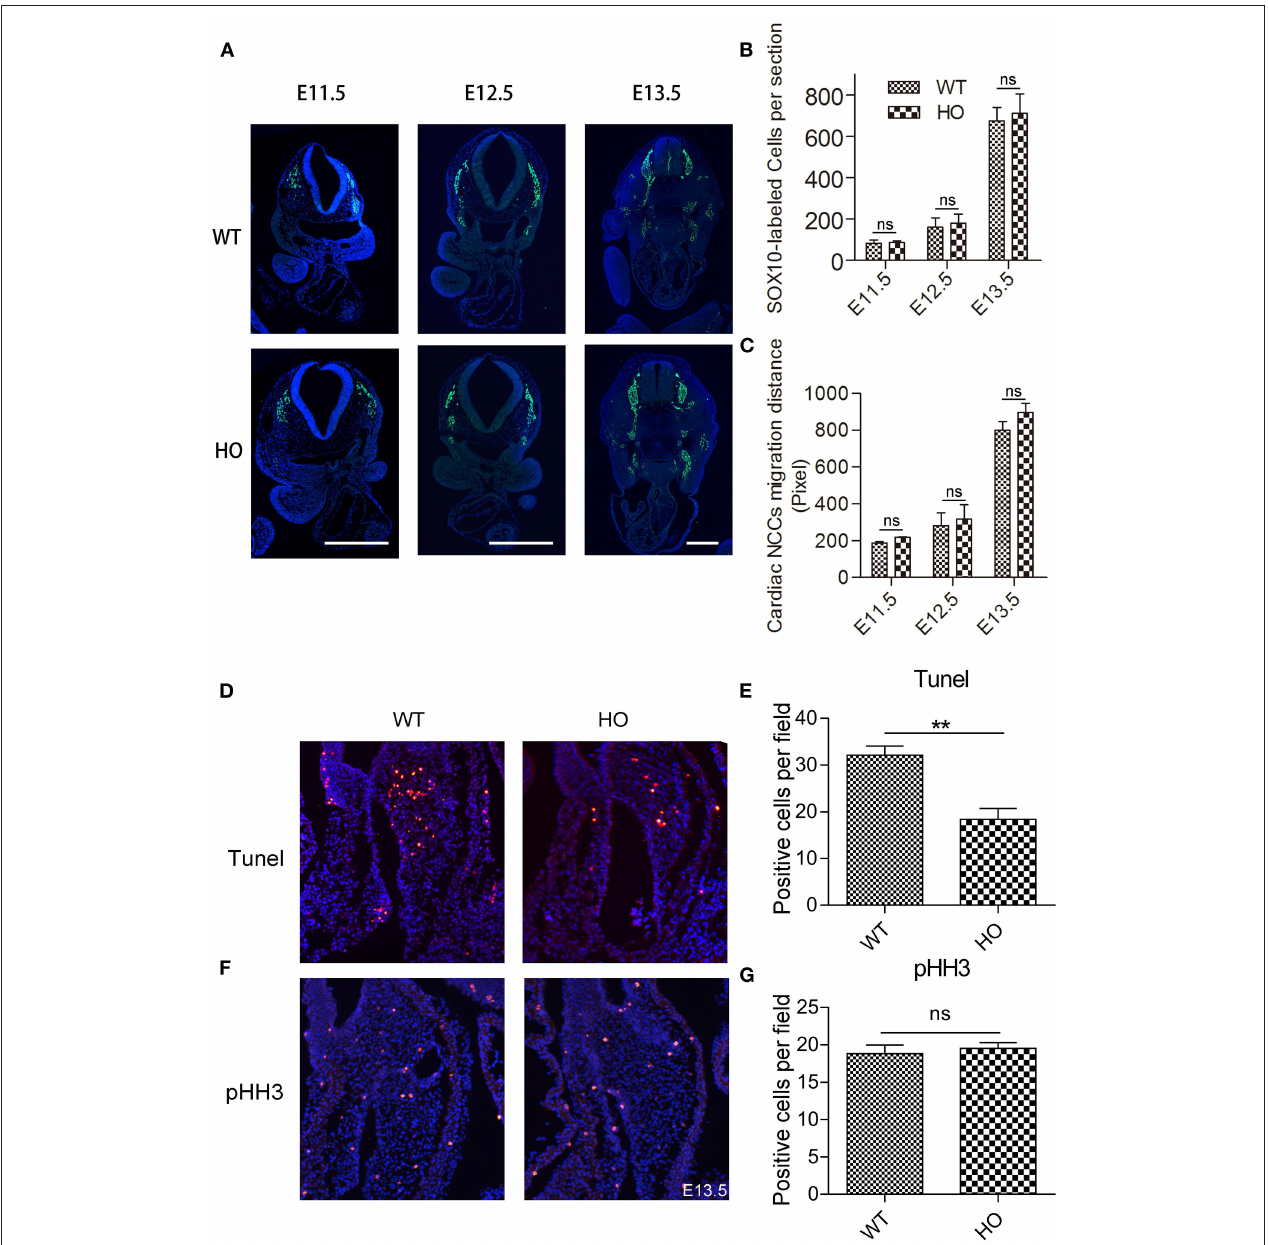
FIGURE 4 | Knockout (KO) of SNX17 does not affect migration and the number of cardiac neural crest cells (cNCCs), but suppresses cellular apoptosis in the cardiac OFT cushion. (A) Sox10-labeled cNCCs in sections from embryos at E11.5 to E13.5. (B,C) Quantification of Sox10-labeled cNCCs number and migration distance. n = 6 embryos per group. (D) Results from terminal deoxynucleotidyl transferase (TdT)-mediated dUTP nick-end labeling (TUNEL) assay showing significant suppression of cell apoptosis in HO relative to WT. (E) Quantification of TUNEL-positive cells for data were shown in (D) . n = 6 embryos per group. (F) Cell proliferation measured by phosphohistone H3 (pHH3) immunohistochemical staining was significantly unchanged between HO and WT rats. (G) Quantification of pHH3-positive cells. Blue, DAPI. n = 6 embryos per group. ** p <